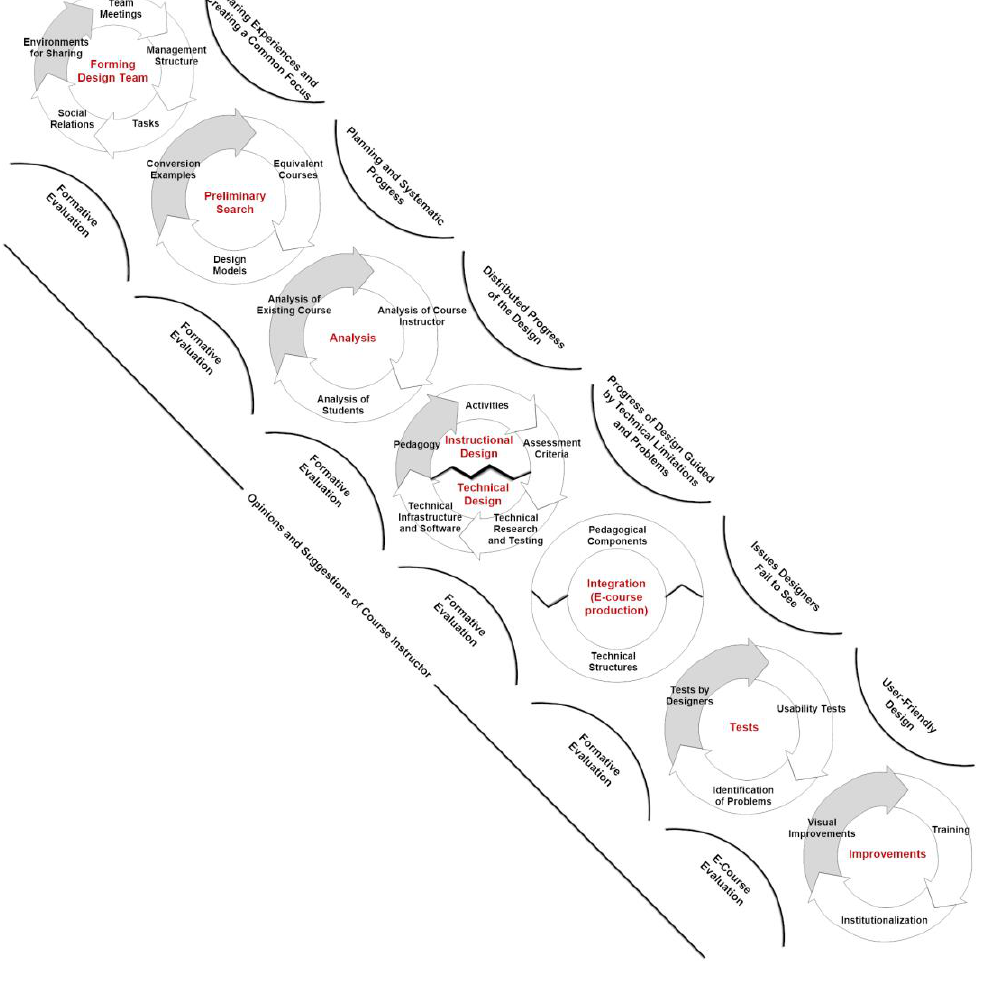
Figure 2 . Experience-based e-course design